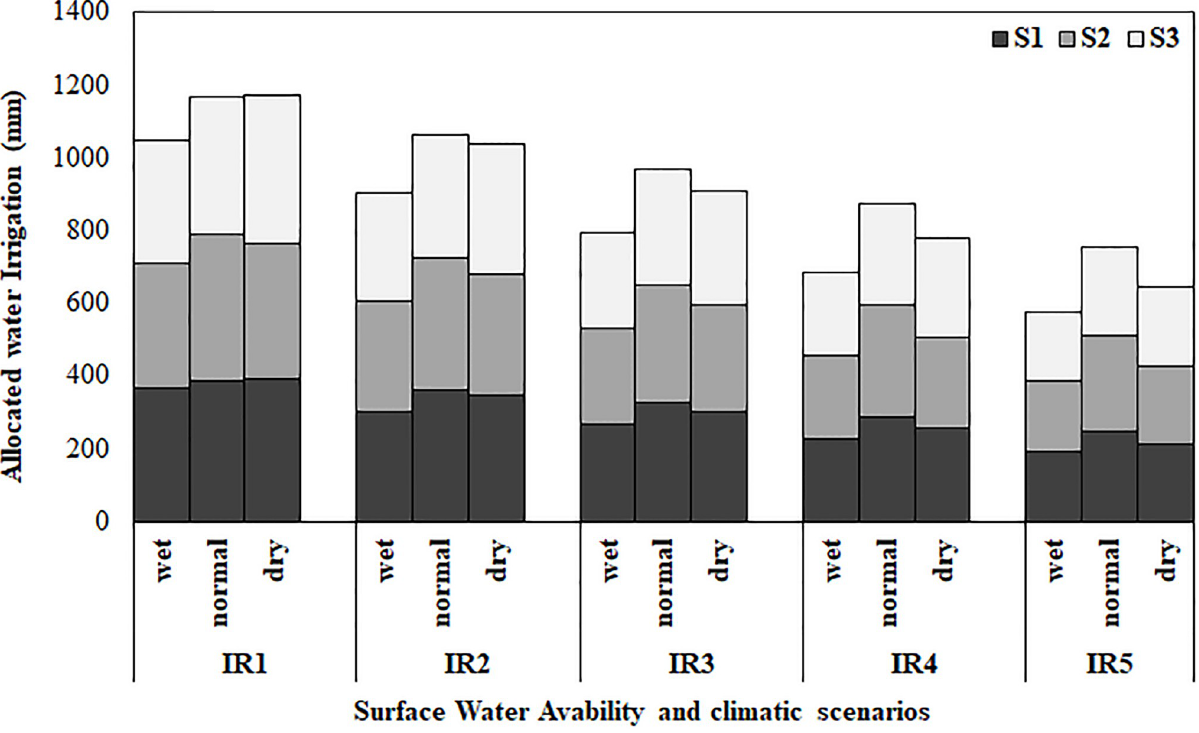
Fig 4. Optimal allocation of irrigation water amount for different soil (S1: Soil type1 (EC < 4), S2: Soil type 2 (4 < EC < 8), S3: Soil type 3(EC > 8)) at different levels of water availability (IR1: No water stress, IR2: 10% water stress, IR3: 20% water stress, IR4: 30% water stress, IR5: 40% water stress) under different climatic conditions (wet, normal, dry